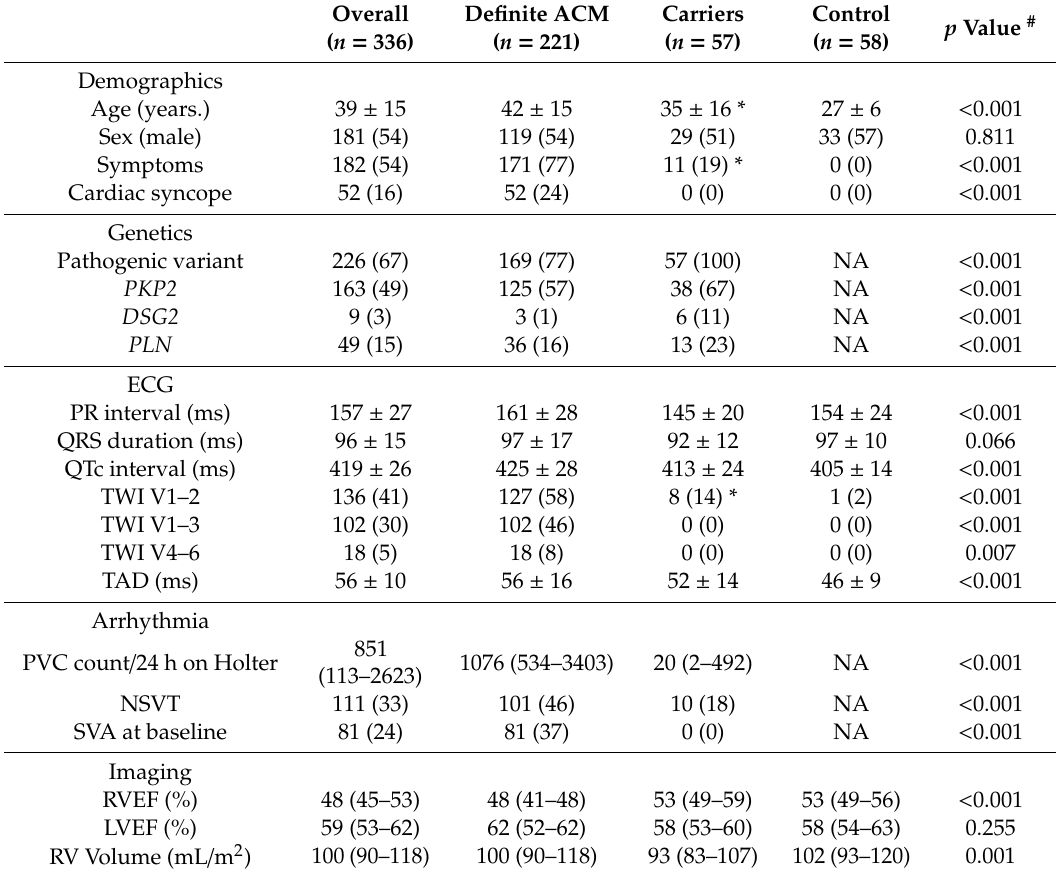
Table 1. Baseline